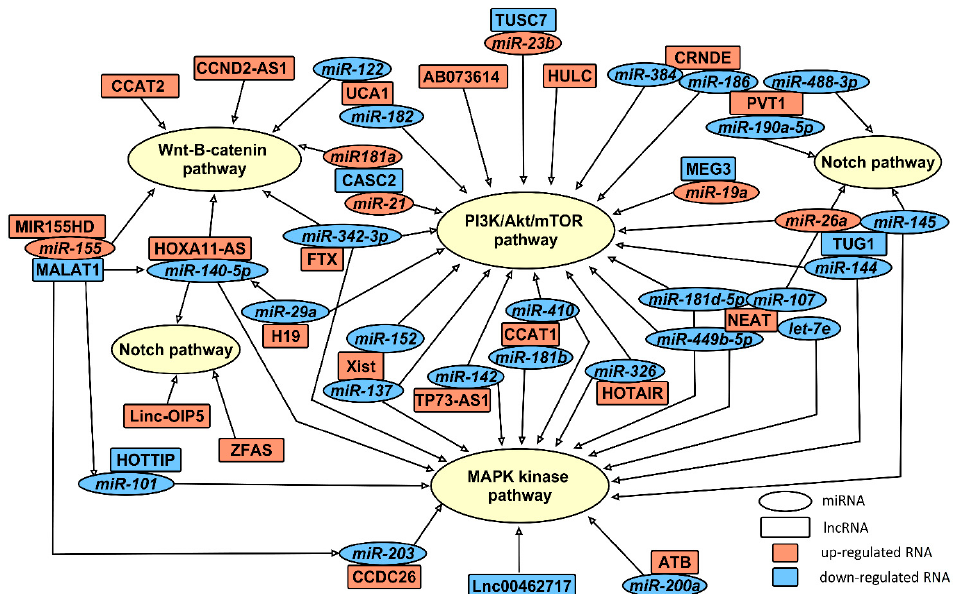
Figure 2. LncRNA and miRNA pathway regulation network. Rectangles represent long-non-coding RNA and ovals-miRNA which are the target/targets of lncRNA. Red color indicates up-regulates RNA in glioma, and blue-down-regulated RNA in glioma. Arrows indicate the signal transduction pathway affected.